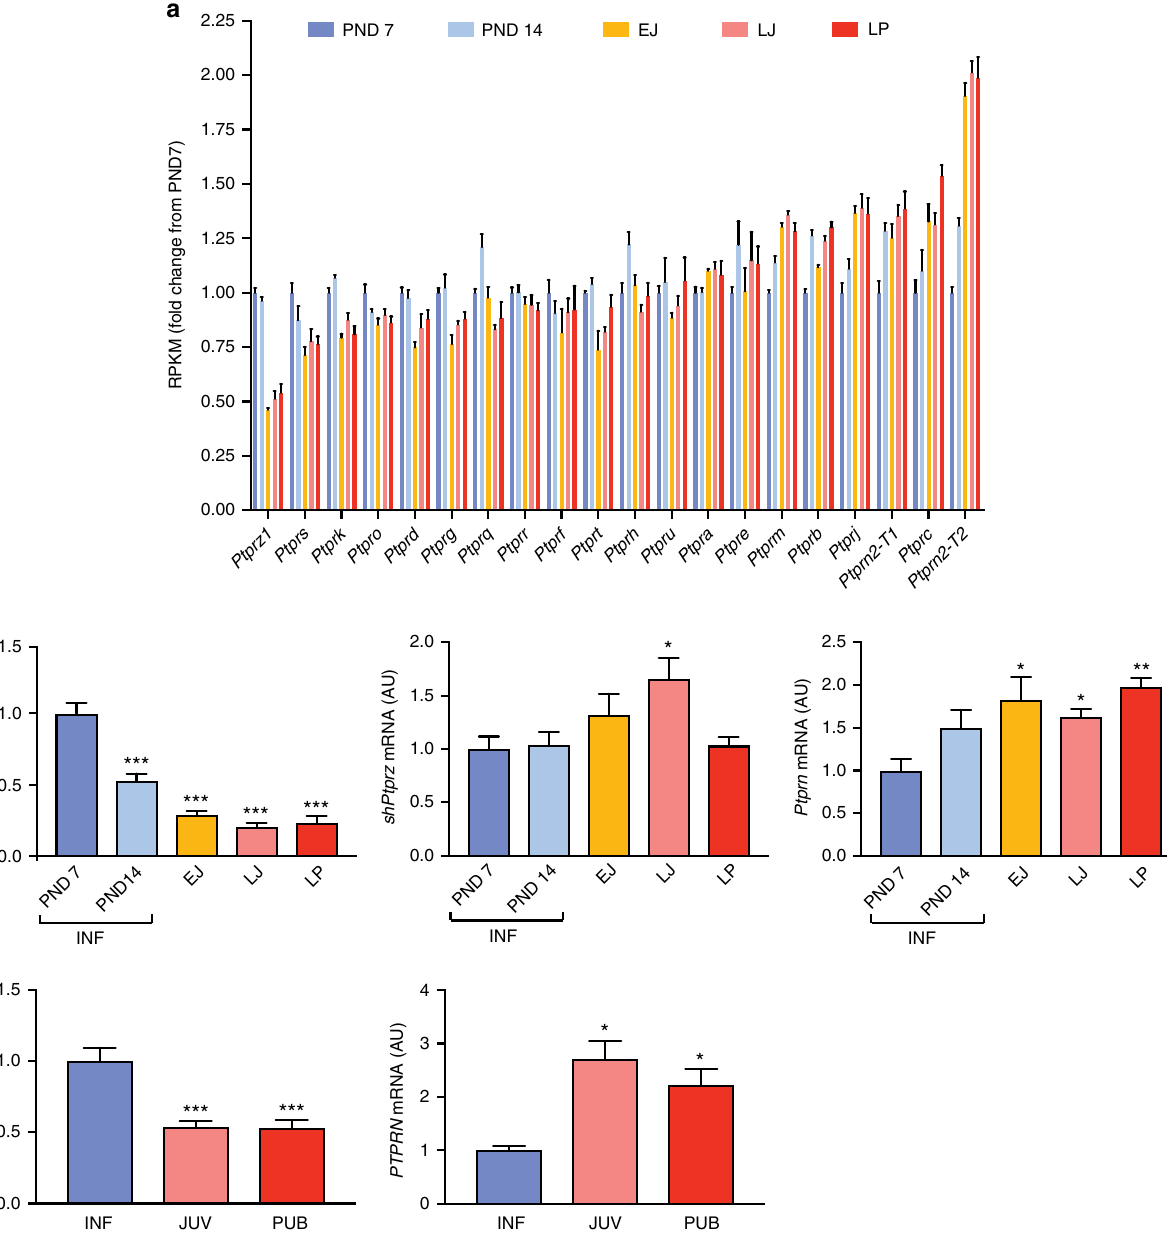
Fig. 3 Changes in hypothalamic PTPR gene expression during prepubertal development of female rats and rhesus monkeys. a PTPR mRNA levels in the medial basal hypothalamus (MBH) of pre – and peripubertal female rats assessed by massively parallel sequencing ( n = 4 biological replicates per developmental stage). b mRNA abundance of two selected Ptpr genes ( Ptprz and Ptprn ) in the MBH of pre- and peripubertal female rats assessed by qPCR. Both the long and short forms of Ptprz are shown. * P < 0.05; ** P < 0.01 and *** P < 0.001 vs. PND 7, one-way ANOVA followed by Student-Newman-Keuls (SNK) multiple comparison test, n = 6 – 8 rats per group. INF = infantile period (PND7 and PND14); EJ = early juvenile (PND21); LJ = late juvenile (PND28); LP = late puberty (day of the fi rst preovulatory surge of gonadotropins). c PTPRZ and PTPRN mRNA levels in the MBH of pre – and peripubertal female rhesus monkeys. * P < 0.05 and *** P < 0.001 vs. infantile (INF) group, one-way ANOVA followed by SNK multiple comparison test, n = 4 – 8 monkeys per group. INF = infantile (1 – 6 months of age); JUV = juvenile (6 – 19 months of age); PUB = pubertal (24 – 36 months of age; de fi ned by the presence of elevated plasma LH levels). Bars represents the mean ± result in hyposmia and structural defects in the hypothalamus in part mediated by RPTP β -contactin interactions during female and pituitary 26 . Directly relevant to the regulation of pubertal reproductive development 27 . Collectively, our human genomic timing is the observation that in prepubertal female mice a short data in European and Japanese datasets, in addition to these isoform of PTPRZ1 (also known as RPTP β ) expressed in astro- animal models suggest that PTPRs are involved in the regulation cytes interacts with the glycosylphosphatidyl inositol-anchored of puberty timing. Additional functional work, particularly link- protein contactin expressed in GnRH neurons 27 . Because con- ing our identi fi ed sequence variation to PTPR function in humans, is required to help further understand the role this gene tactin is particularly abundant in GnRH nerve terminals, it has family plays in pubertal regulation. been postulated that GnRH neuron-astrocyte communication is